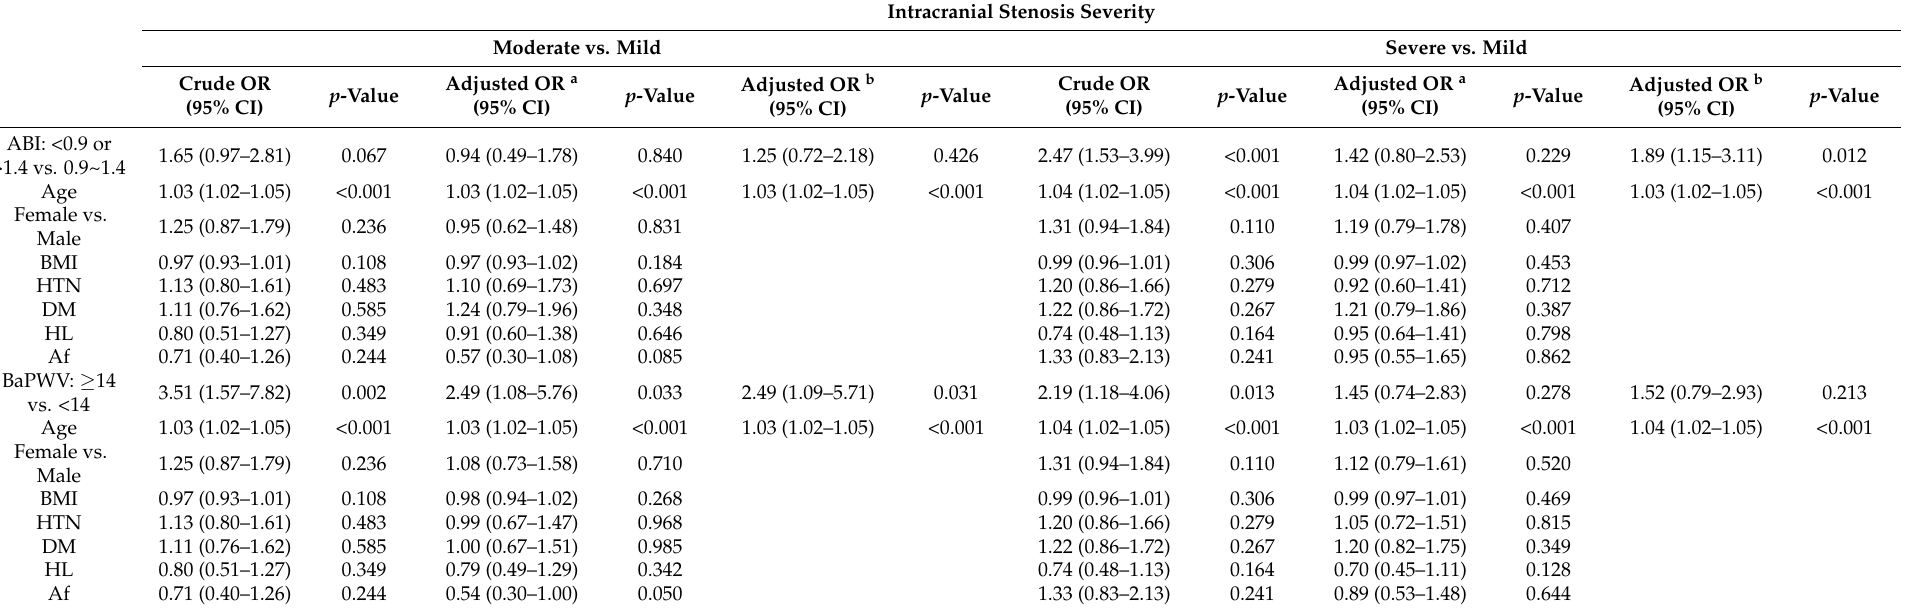
Table 2. Multinomial logistic regression for predictors of intracranial vessel